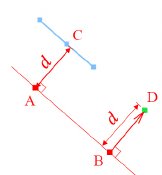
Figure 17. Complementing with missing points. The blue line is the correct lane line. Point A is the trajectory point that corresponds to the blue line, and point B is the trajectory point that corresponds to the missing line. By drawing a line perpendicular to AB through point A , this line intersects the blue line at point C . The distance d of AC is calculated, and point B is moved distance d along the orthogonal direction of AB to point D , which is the complementary lane line